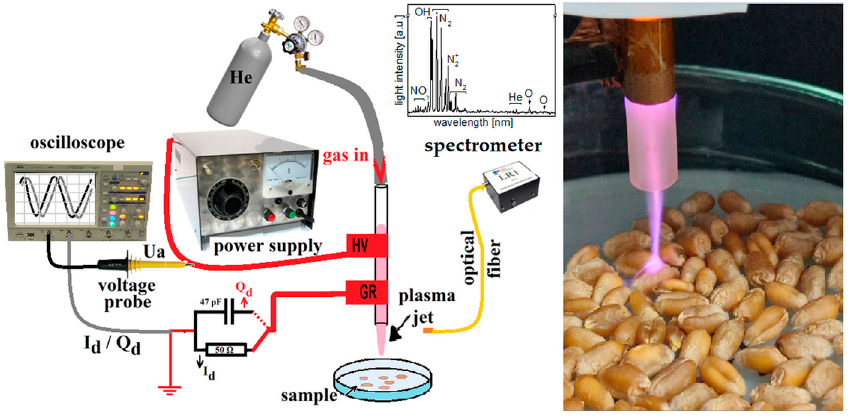
Figure 1. Experimental set-up ( left ) and a photograph ( right ) of the plasma source in interaction with the wheat seed samples and the electro-optical diagnosis arrangement.